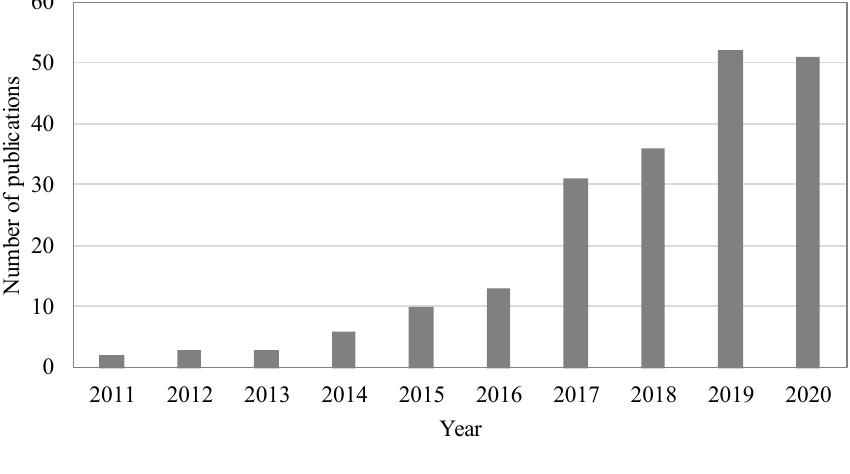
Figure 2. Number of published articles on LCZ classification and mapping in recent years (search date: 27 August